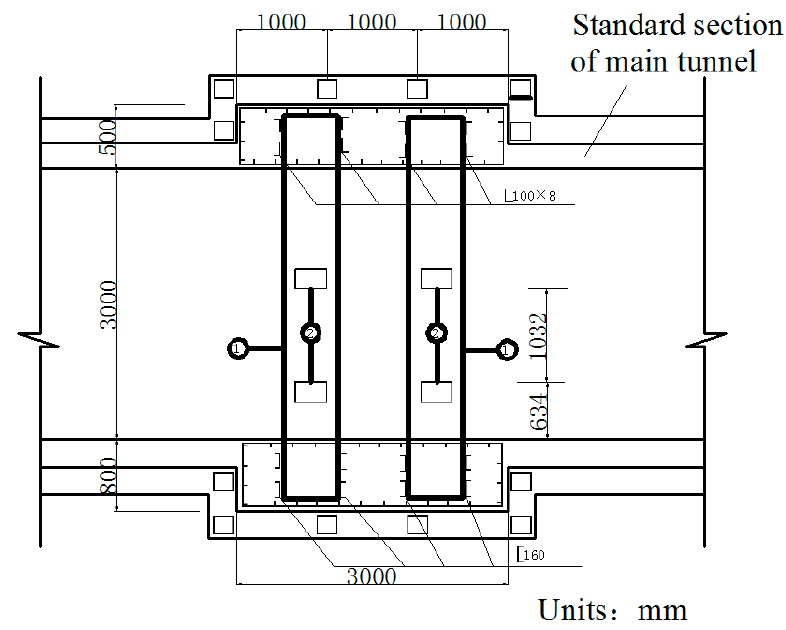
Figure 2. Thickened section on lining near the fixed brackets.